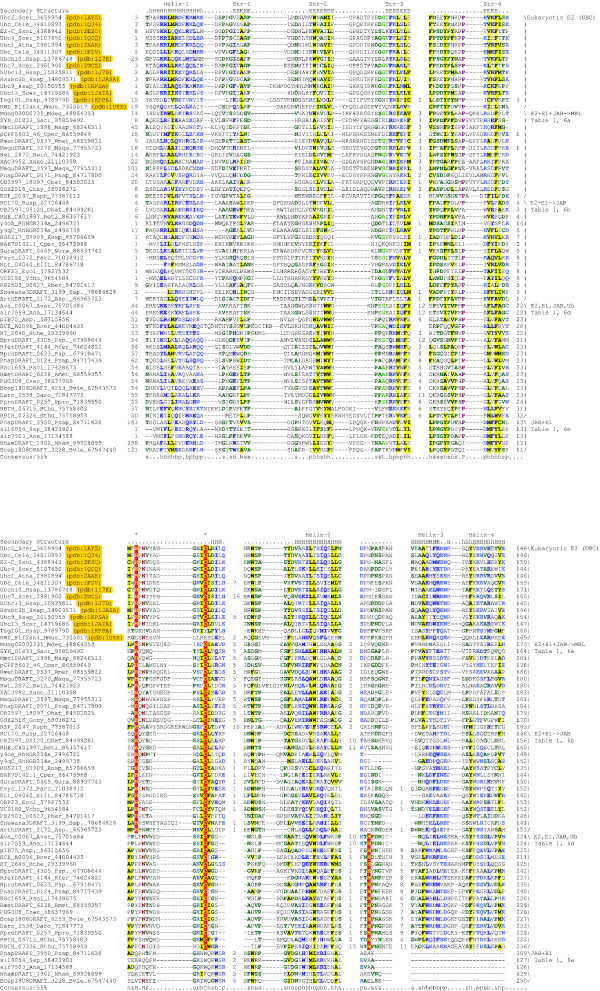
Multiple alignment of E2 (UBC)-like proteins with a special emphasis on bacterial versions. PDB identifiers of primary sequences derived from crystal structures are shaded in gold. Coloring is indicative of 55% consensus. The secondary structure, shown on the second line of the alignment, is derived from a general consensus of the secondary structure features from the different crystal structures shown in the alignment. Other features of the alignment are the same as in Figure 2, including coloring scheme, consensus abbreviations and secondary structure representations. Additionally, conserved polar residues (p; CDEHKNQRST) are colored blue. The strongly conserved proline and asparagine residues are colored purple brown respectively. The strongly conserved cysteine and histidine residues described in the text are shaded red and are also marked with an asterisk above their positions in the alignment. The major families of bacterial E2s are shown to the right. Also shown are the row numbers in Table 1, where a particular family is described. See the legend to Figure 2 for species abbreviations.